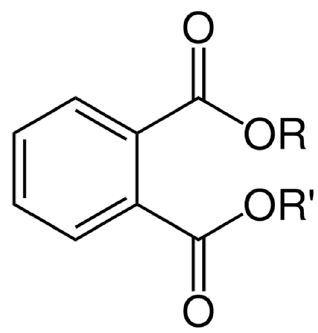
Figure 2. Chemical structure of phthalates (R: alkyl group).